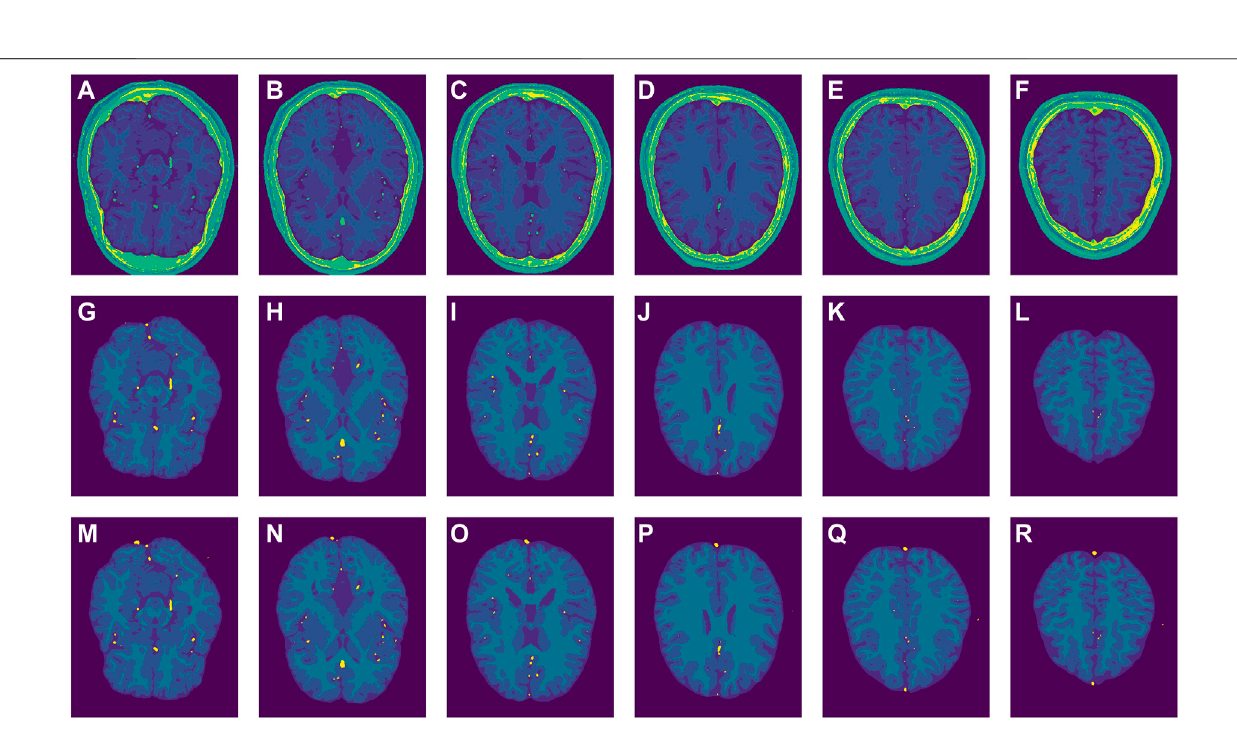
FIGURE 4 | Brain segmentation of images from the second data set using the minimum spanning tree. (A-F) Representative axial MRI sections of brains. (G – L) Segmented images (A – F) using the minimum spanning tree. (M – R) Ground truth images: obtained from the labels representing cerebrospinal fl uid, gray matter, white matter and